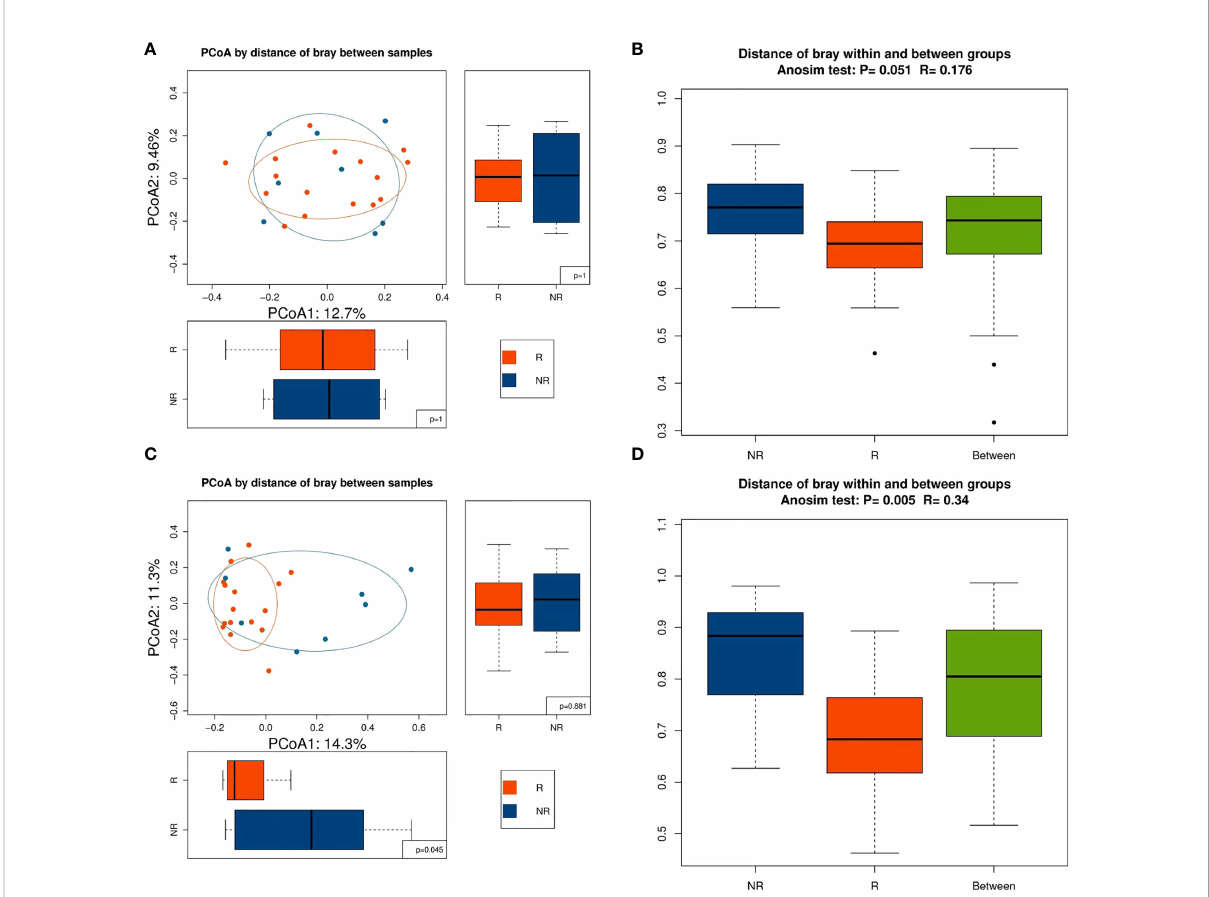
FIGURE 3 Beta diversity between the R (n = 16) and NR (n = 8) groups. (A) Beta diversity was evaluated by PCoA and (B) ANOSIM at baseline. (C) Beta diversity was evaluated by PCoA and (D) ANOSIM at 6